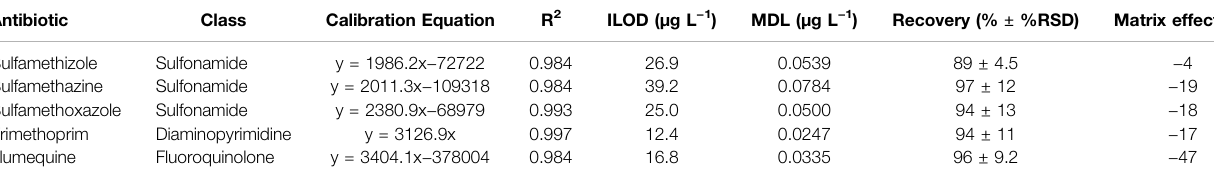
TABLE 1 | Method validation